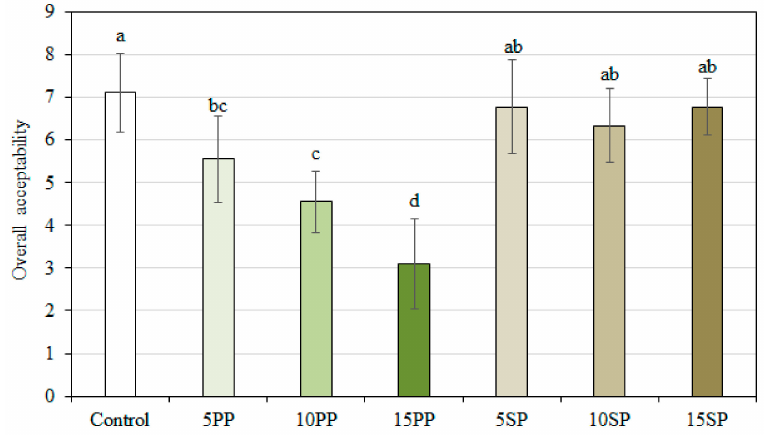
Figure 4. Mean of the overall acceptability of the breads. The different letters show a significance difference ( p <